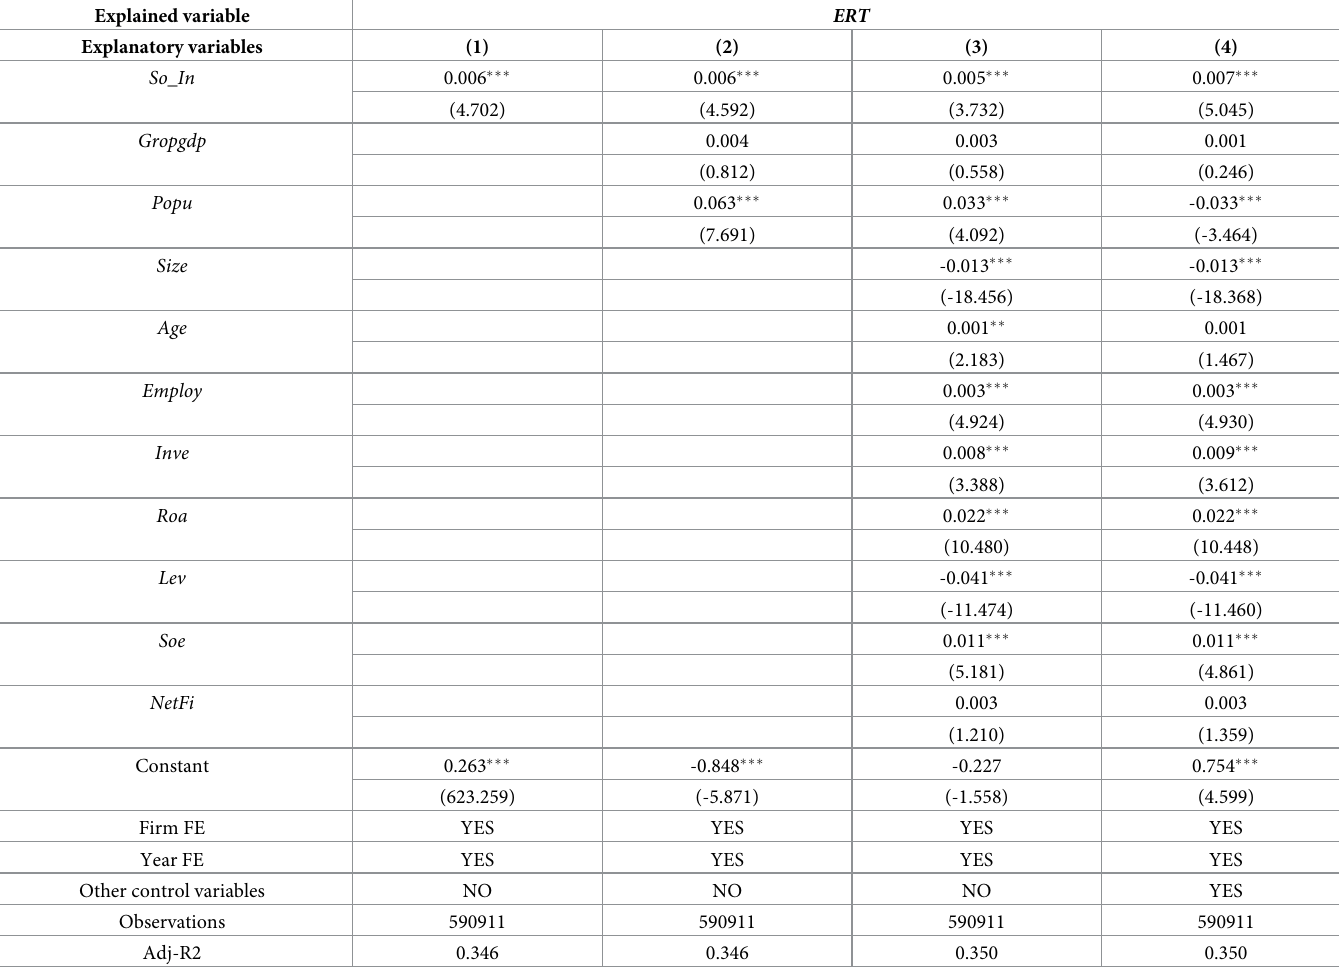
Table 2. Benchmark regression: Social insurance collection institution and corporate tax